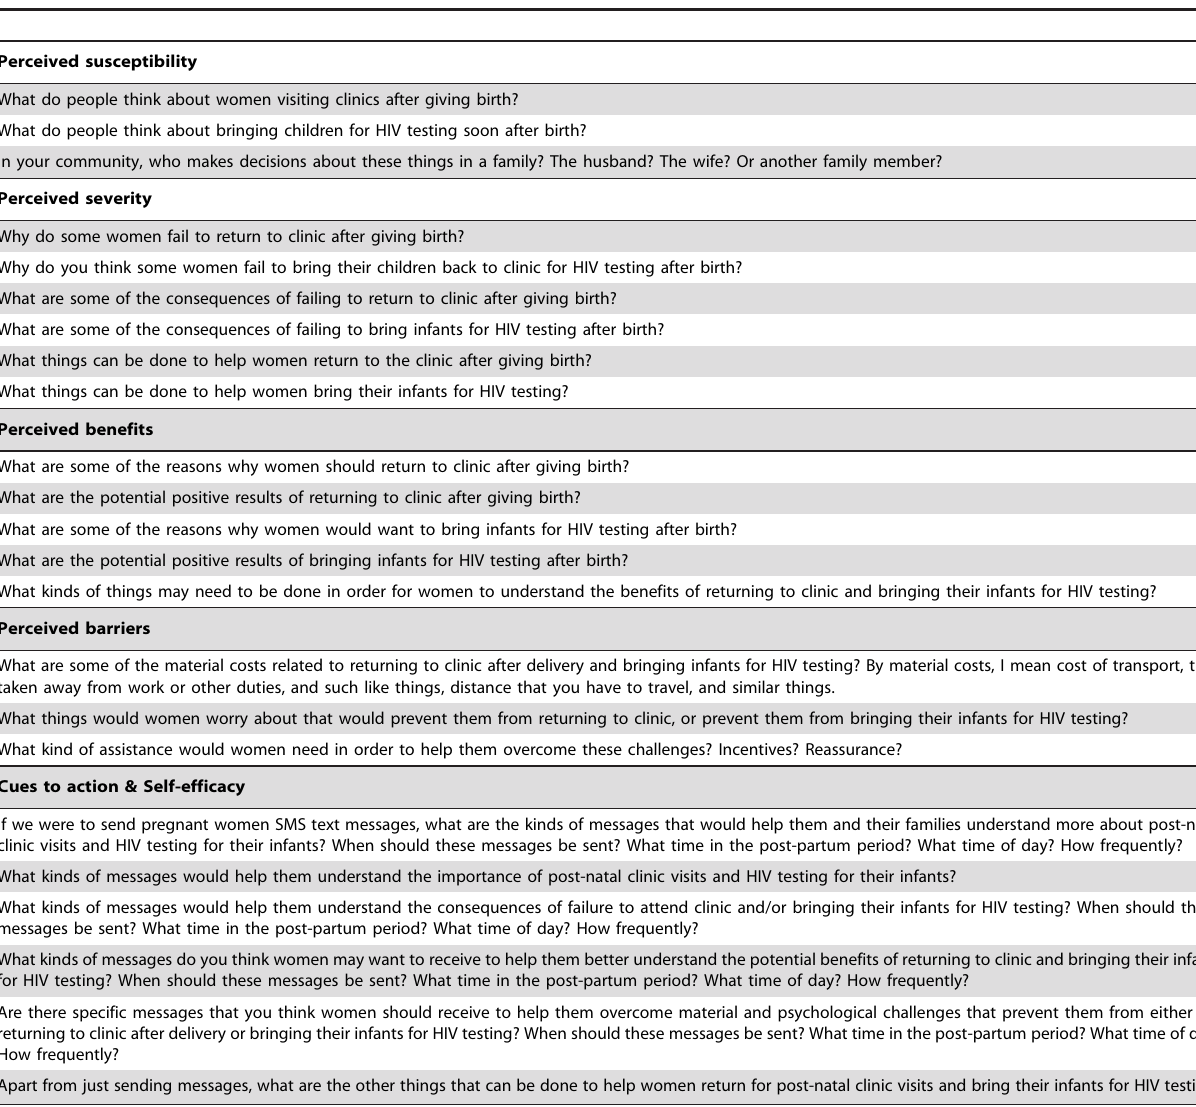
Table 1. Focus group discussion questions grouped by Health Belief Model